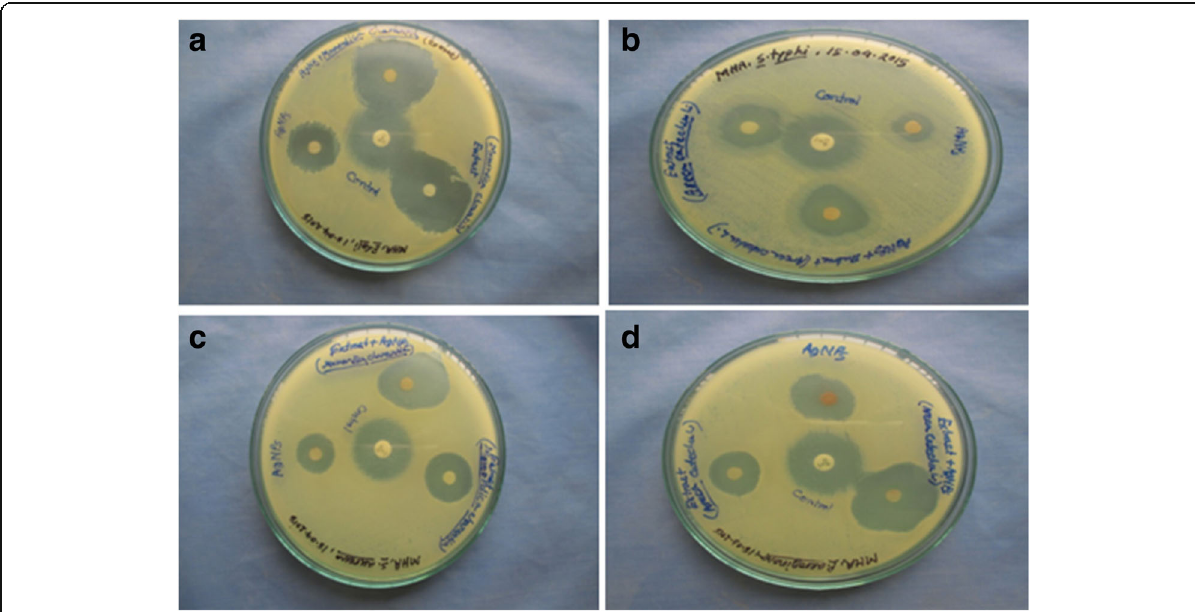
Fig. 5 Antibacterial activities of M. charantia , AgNPs, Ag-Extract-NPs against- a E. coli b S. typhi c S. aureus d P. aeruginosa